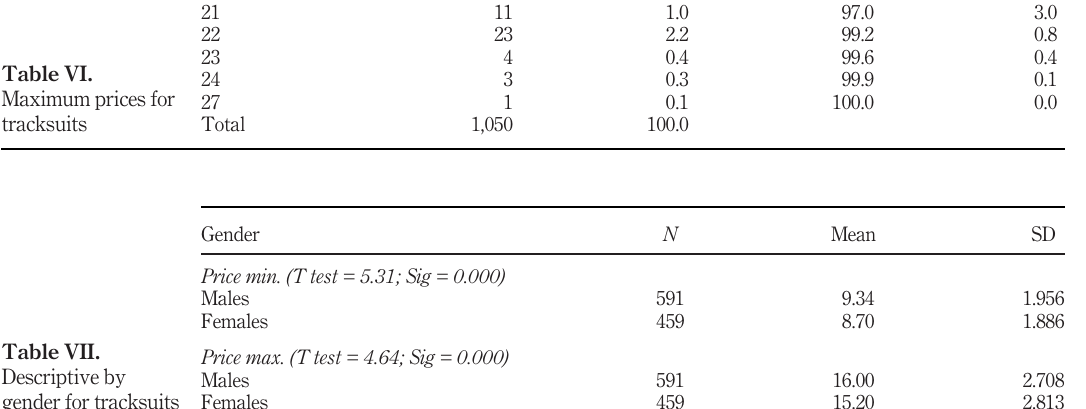
Table VII. Descriptive by gender for tracksuits